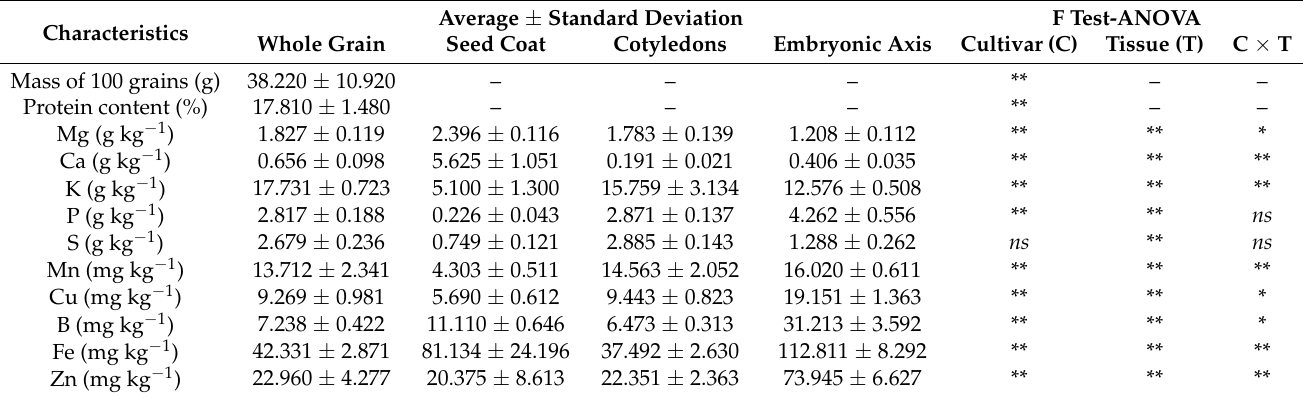
Table 1. Analysis of variance (ANOVA), mean values, and standard deviation of the characteristics 100-grain mass (M100), protein content (Prot), and contents of 10 evaluated minerals in the whole grains and constituent tissues (seed coat, cotyledons, and embryonic axis) of 10 bean ( Phaseolus vulgaris L.) cultivars derived from different centers of origin. Characteristics Mass of 100 grains